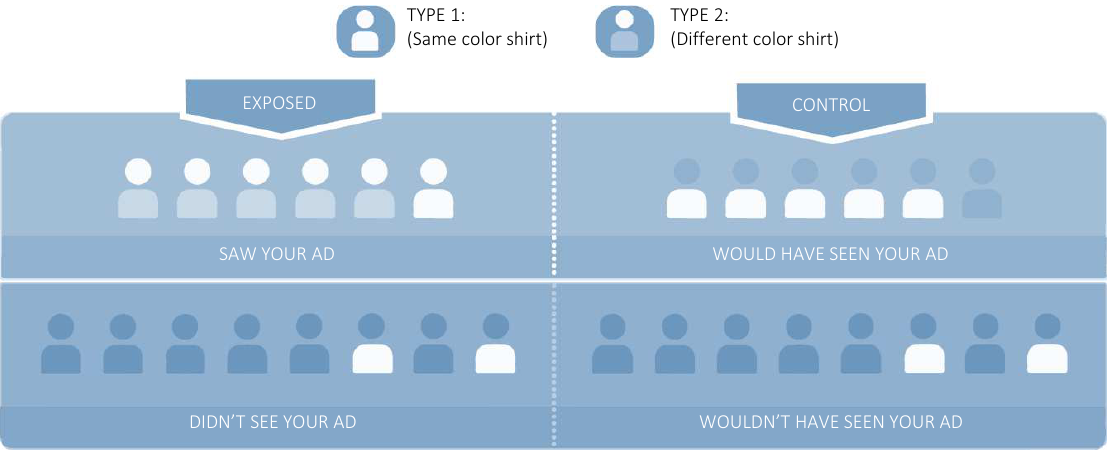
Figure 3. The principle of A/B testing with the Conversion Lift and Facebook